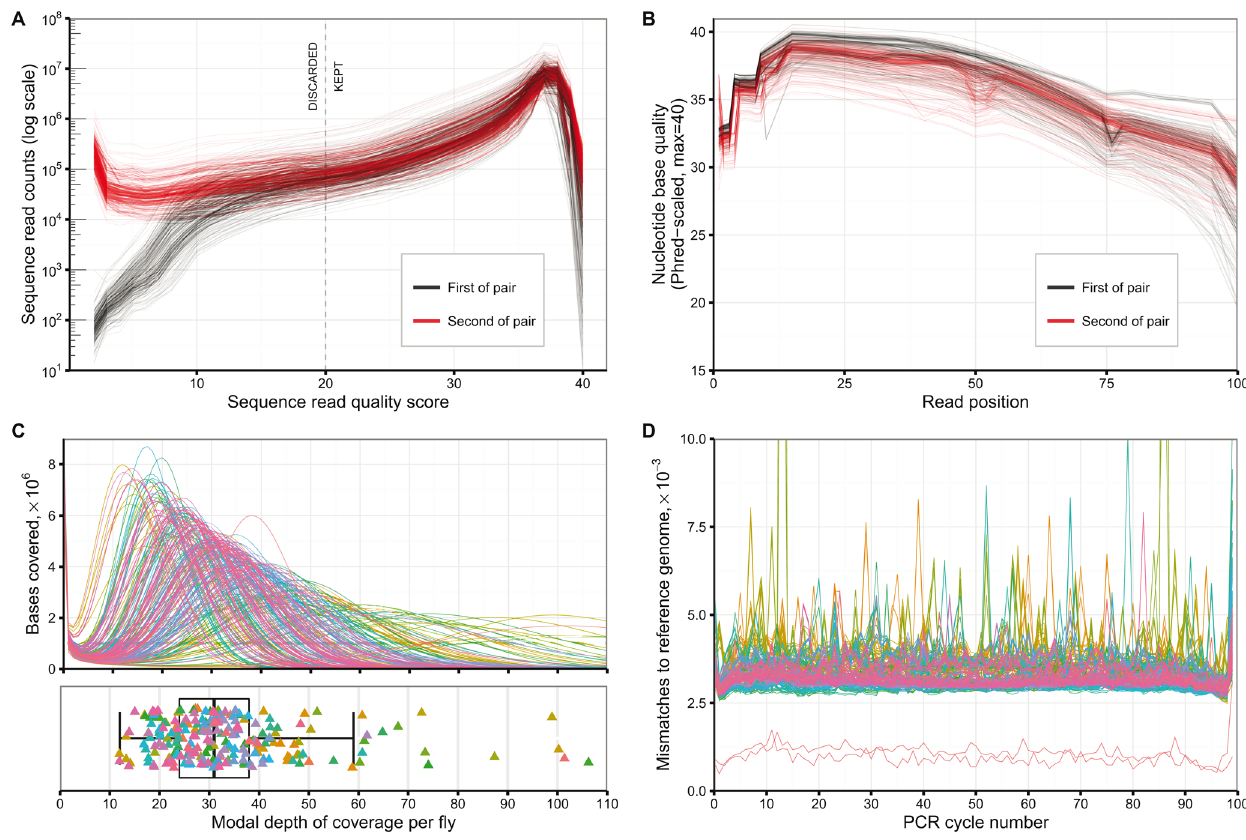
Figure 3. Next-generation sequencing assessment. A : Sequence read quality for each sample sequenced. Y-axis scale is logarithmic. B : Quality of sequences by nucleotide base position for each sample. C : Read depth of coverage distribution across each sample. Colouring corresponds to the order which which the samples were originally sequenced. D : Mis-matches to the dm6 reference genome assembly, by PCR cycle-number. Colouring is by sample as in plot C . The two red lines with visibly-lower mismatch rates than the others correspond to the two in-house BDGP/dm6 reference lines that were sequenced. Data and R code for this figure are located at https://doi.org/10.5281/